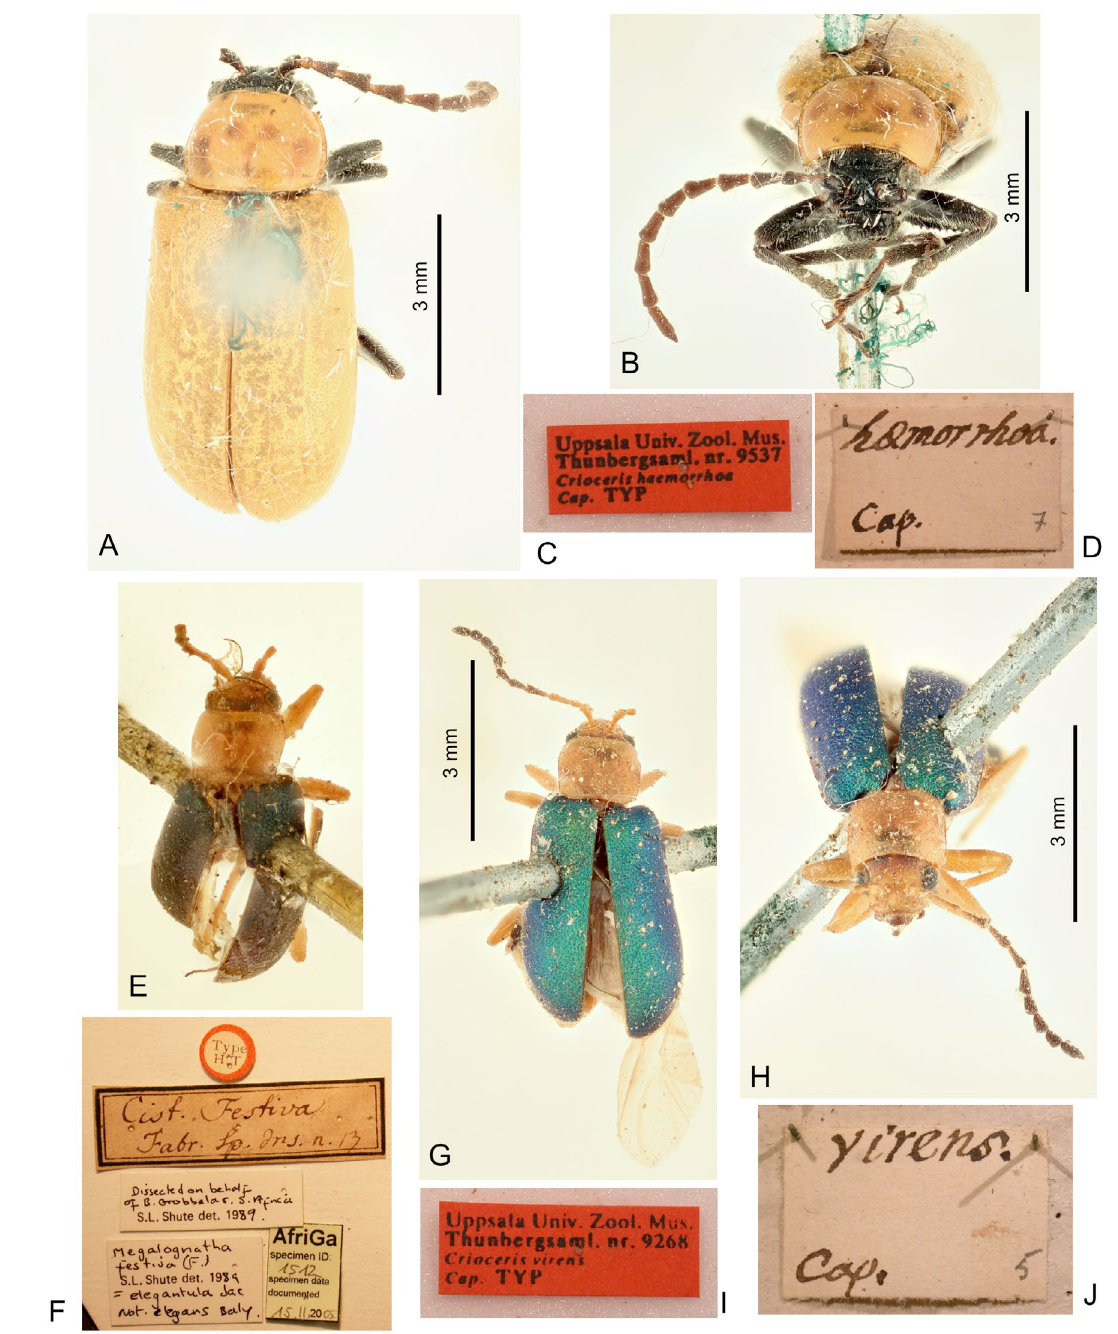
Fig. 14. A–D . Exosoma lusitanica (Linnaeus, 1767), holotype of Crioceris haemorrhoa Thunberg, 1827, ♂, 8.0 mm, UUZM. A . Dorsal view. B . Frontal view. C . Label. D . Box label. E–J . Megalognatha festiva (Fabricius, 1781). E–F . Holotype of Cistela festiva Fabricius, 1781, ♀, not measured, BMNH. E . Dorsal view. F . Labels. G–J . Holotype of Crioceris virens Thunberg, 1827, ♀, 4.5 mm, UUZM. G . Dorsal view. H . Frontal view. I . Label. J . Box